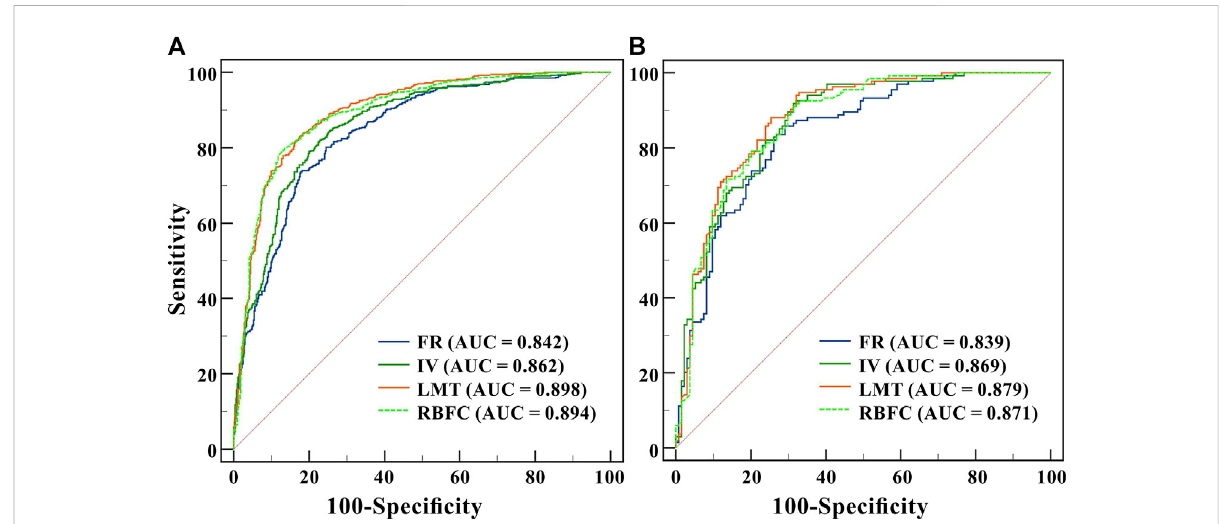
FIGURE 8 ROC curves and AUC for the FR, IV, LMT, and RBFC models: (A) training dataset and (B) validation